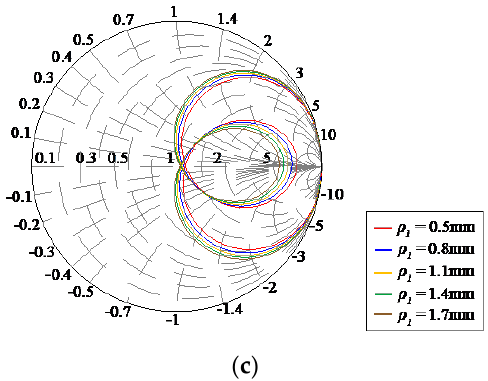
Figure 4. Wire diameter characteristic of input impedance: ( a ) spiral resonator, ( b ) folded spiral resonator with a single-layered structure, and ( c ) folded spiral resonator with a double-layered structure. to a transmission efficiency for 50 Ω load impedance. is obtained from the Z parameters through the S parameters [34]. 𝜂𝜂 max